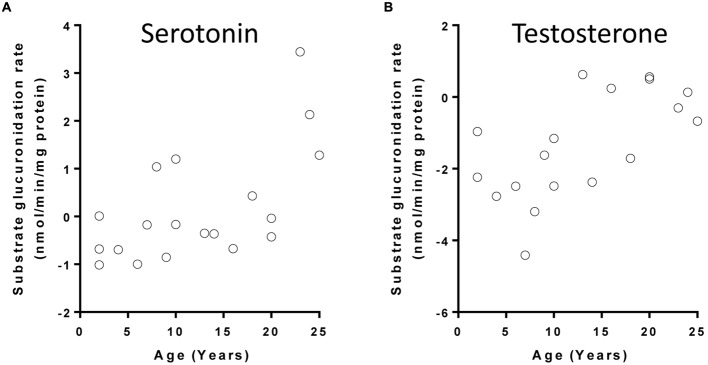
Correlation between age and UGT substrate glucuronidation rates in children liver microsomes: (A) serotonin; (B) testosterone. Glucuronidation rates (+log2 transformed) of UGT substrates had been previously determined (Kang et al., 2010; Liu et al., 2014).